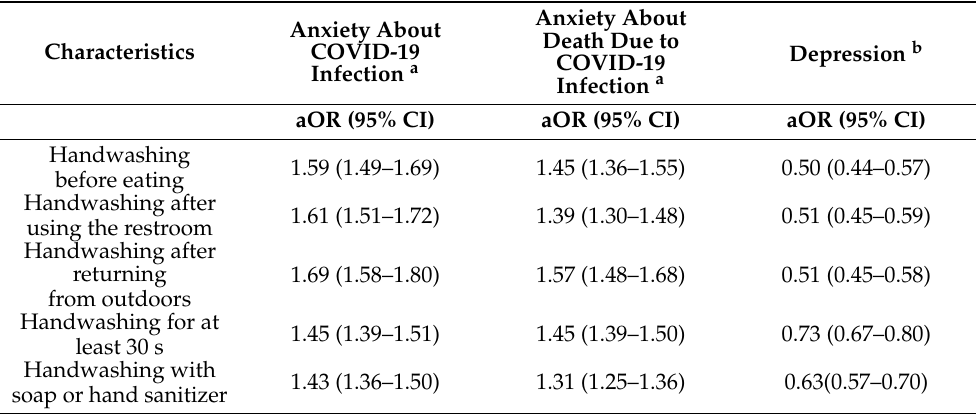
Table 4. Association between psychological problems and hand hygiene practices among people with HTN or DM during the COVID-19